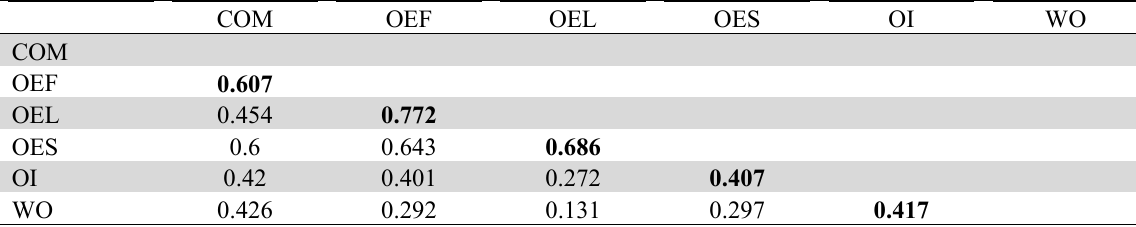
Findings of Measurement Model for Formative construct (Organization Embeddedness) Outer